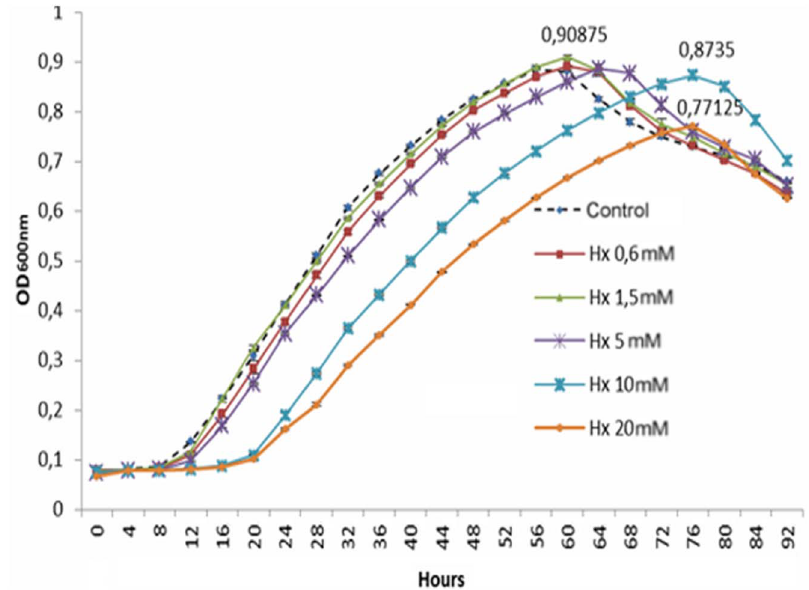
Figure 1. Influence of different hexanoic acid (Hx) concentrations on the growth rate of Pst DC3000. The results are presented as growth curves (in hours) of Pst DC3000 during its culture in the presence of 0.6, 1.5, 5, 10, and 20 mM Hx. The optical density at 600 nm was measured at 10- min intervals. The results represent the means with standard deviation.